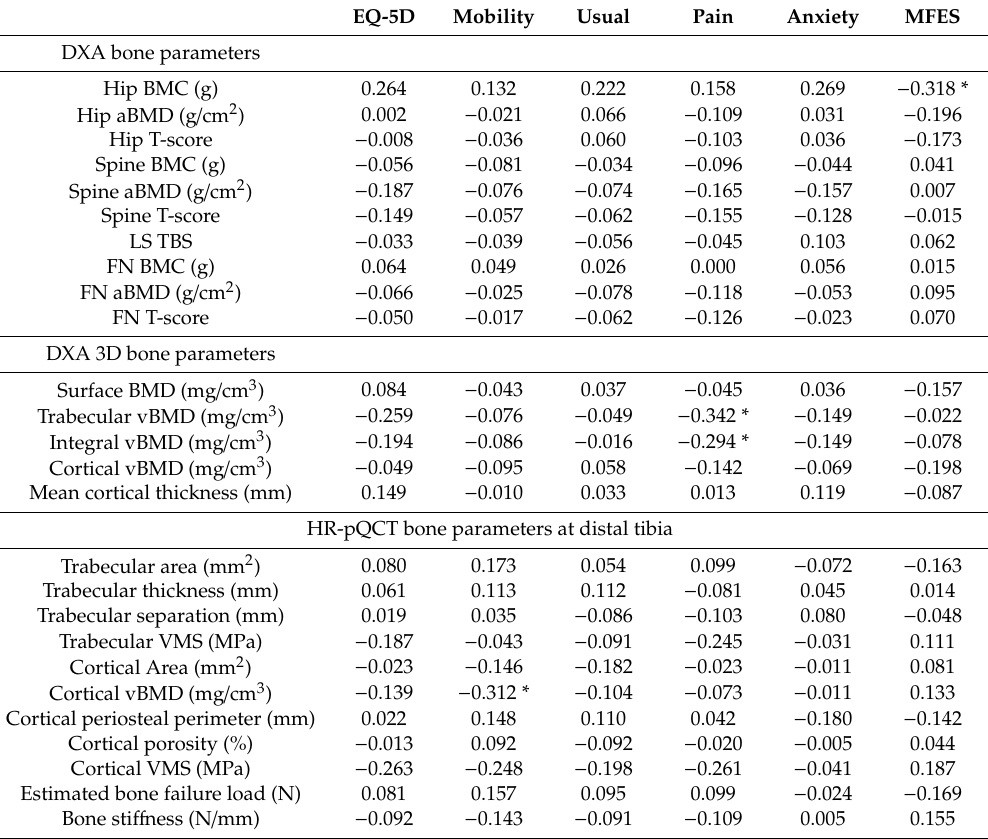
Table 2. Spearman’s correlations between self-reported measurements and bone parameters.